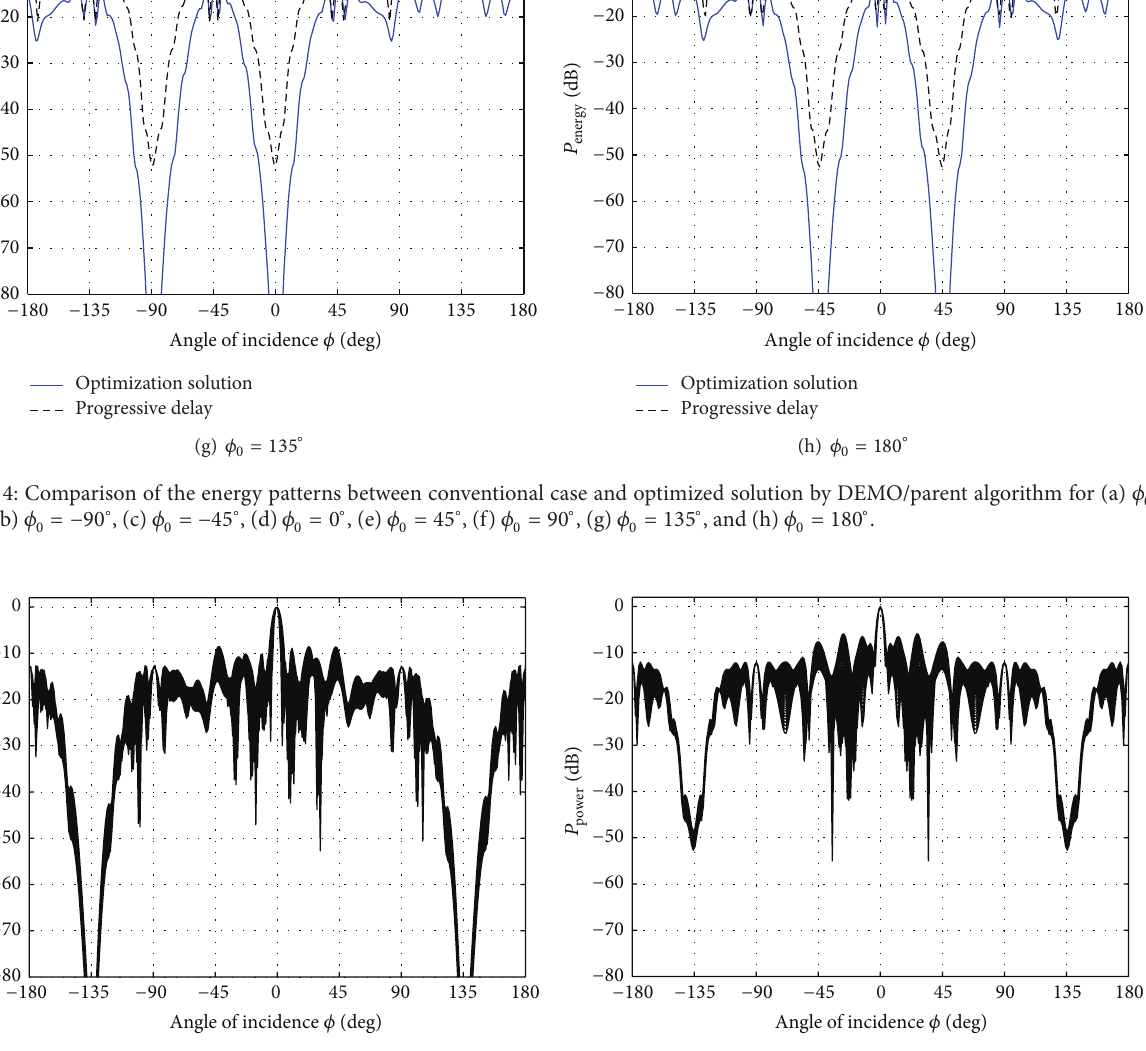
Figure 5: Spectrum in frequency of (a) optimized solution and (b) conventional case, for 𝜙 0 = 0 .